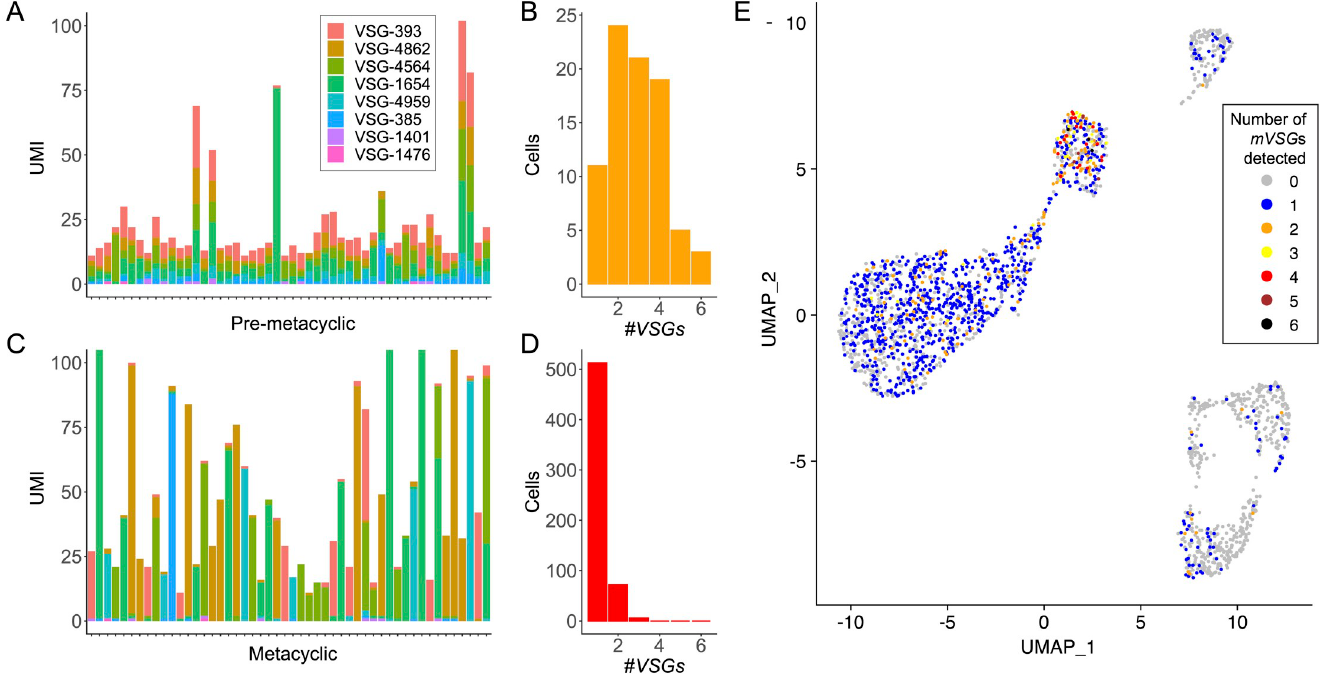
Fig 5. Developmental progression of VSG expression. A. VSG expression data for a random subset of 50 pre-metacyclic cells, with a total VSG UMI count > 10. Data are raw (unscaled) UMI counts. Each column represents a cell and each colour a different VSG . B. Histogram showing the number of VSG expressed for all pre- metacyclic cells (per VSG UMI count > 2, all cells in cluster). C. As for A except that the data are a subset of 50 metacyclic cells with total VSG UMI counts > 10. D. Histogram as for B except showing metacyclic VSG transcript diversity (per VSG UMI count > 2, all cells in cluster). E. UMAP projection from Fig 2B coloured according to the number of mVSG genes detected per